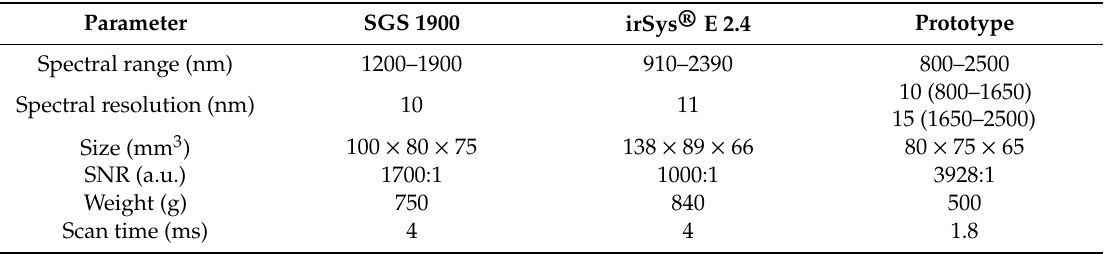
Table 3. A comparison of the Corresponding parameters of the SGS 1900, the irSys ® E 2.4, and the spectrometer